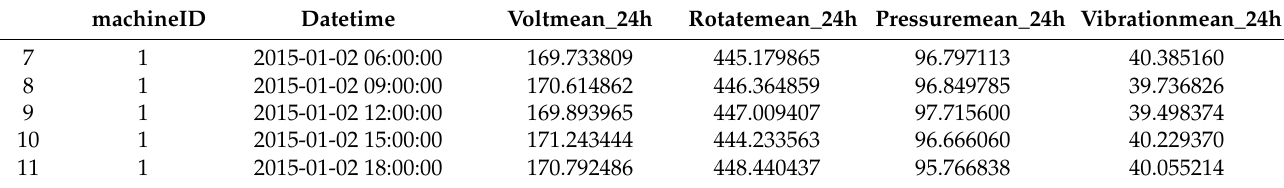
Table 8. Example of Lag Features for telemetry data in real time, with N = 24.